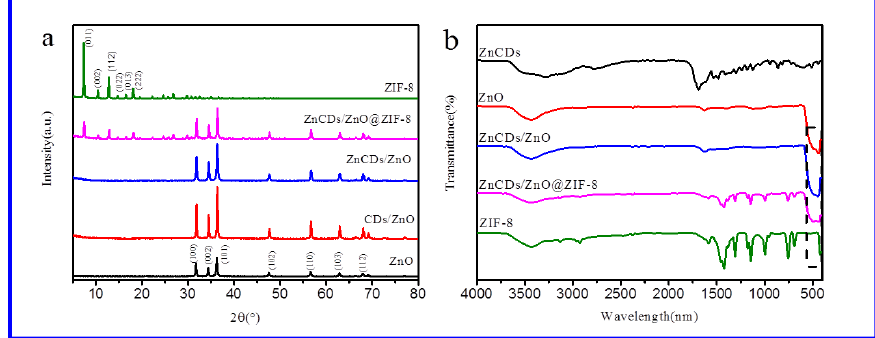
Figure 3. ( a ) XRD and ( b ) IR of ZnCDs/ZnO@ZIF-8 composites and related materials. The FT-IR spectra also confirm the successful synthesis of the composites (Figure 3b). The ZIF-8 and ZnCDs/ZnO@ZIF-8 both exhibits adsorption peaks at 424, 752, 1141, 1306, 1423, 1582, 2928, and 3143 cm − 1 , The adsorption peaks at 1582 cm − 1 is attributed to the stretching vibration of C=N bonds. The adsorption peaks at 752, 1141, and 1306 cm − 1 are attributed to the bending vibrations of the imidazole ring, while the one at 1423 cm − 1 is attributed to the stretching vibration of the imidazole ring [21,32]. The adsorption peaks at 2928 cm − 1 and 3143 cm − 1 are attributed to the aromatic and aliphatic C − H stretches [33]. The widened vibration peak between 400~500 cm − 1 in ZnCDs/ZnO@ZIF-8 could be attributed to the Zn-O stretch in ZnO [28], which indicates ZnCDs/ZnO’s successful modification with ZIF-8.